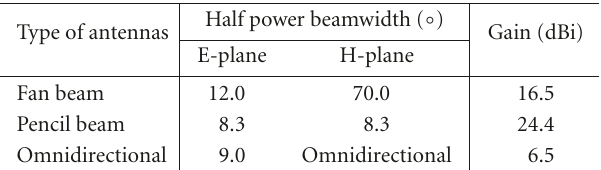
Table 1: Antenna parameters. Table 2: Measurement scenarios and